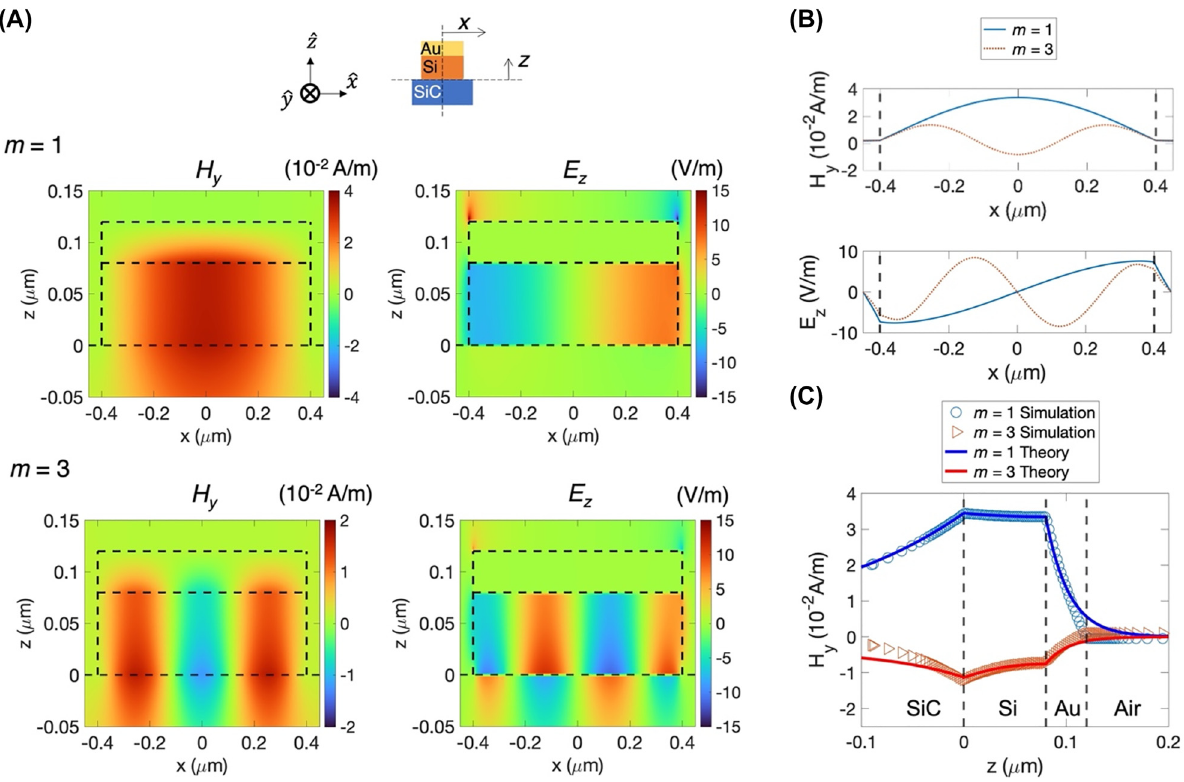
Figure 3: Simulated field profiles at the coupled SPP–SPhP cavity resonance in a thin layered Au (40 nm)–Si (80 nm) grating (900 nm periodicity) on 6H-SiC. The cavity length is 800 nm. (A) Top: Schematic of the device geometry. The x is measured from the center of the cavity, and the z is from the SiC surface. The coupled SPP–SPhP mode propagates along the x -axis with the propagating constant 𝛽 associated with a magnetic field H and an electric field E . Middle: Field distribution of H and E inside the cavity at the half-wave y z y z and E are 90 ◦ out of phase with each other in space and form a standing wave. H has a long evanescent tail resonance condition ( m = 1). H y z y falls away steeply inside Au film. Localized E fields are shown at the top edge of the Au film. Bottom: Field distribution in SiC crystal, but H y z and E inside the cavity at the 1.5 wave resonance condition ( m = 3). (B) The simulated field profiles of H and E along the x -axis in the of H y z y z middle of the silicon layer ( z = 40 nm) at two resonance conditions ( m = 1 and m = 3). (C) The calculated (symbol) and simulated (line) field profiles of H along the z -axis at the cavity center for two resonance conditions. Although the analytic model uses a half infinite slab of Au, y the calculation and the simulation agree well with each other due to the small skin depth of Au